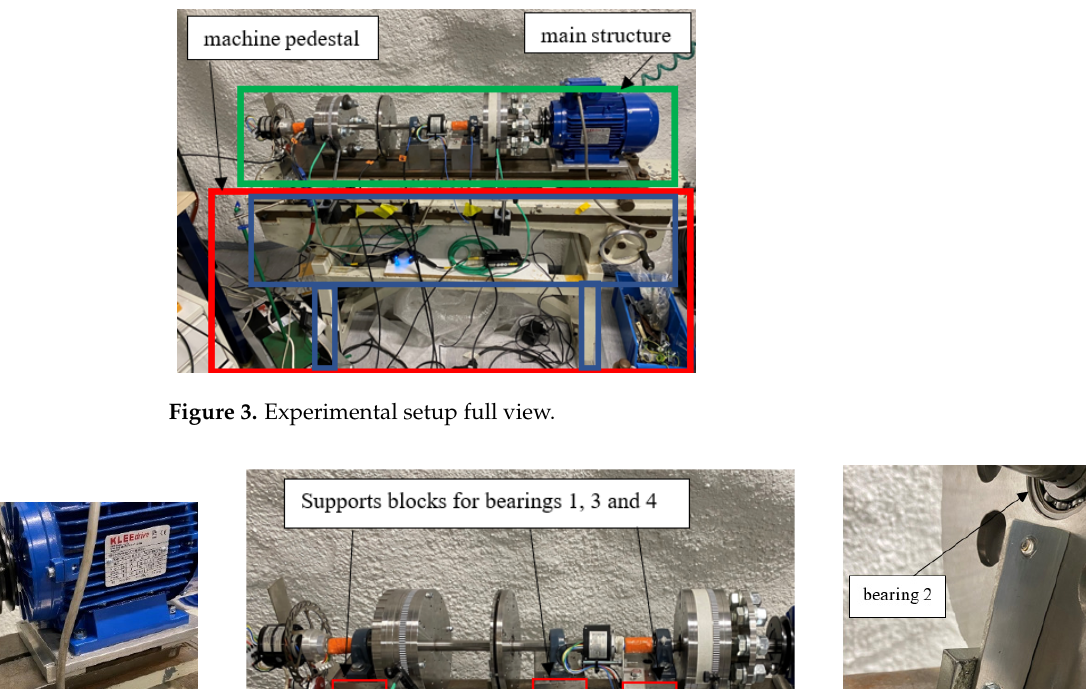
Figure 2. Schematic of the test setup. The overall length of the main rotor is 770 mm, the total mass of the main rotor is 40.27 kg, and the speed range between 200 rpm and 700 rpm, dimensions are in millimeters.